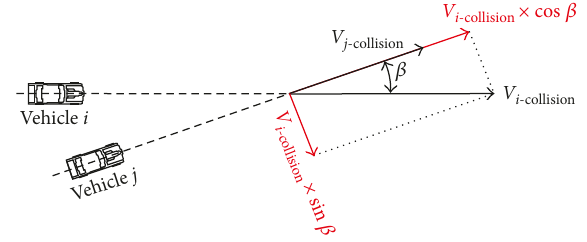
Figure 3: Decomposition of the speed vectors of vehicle i parallel with and perpendicular to the movement direction of vehicle j